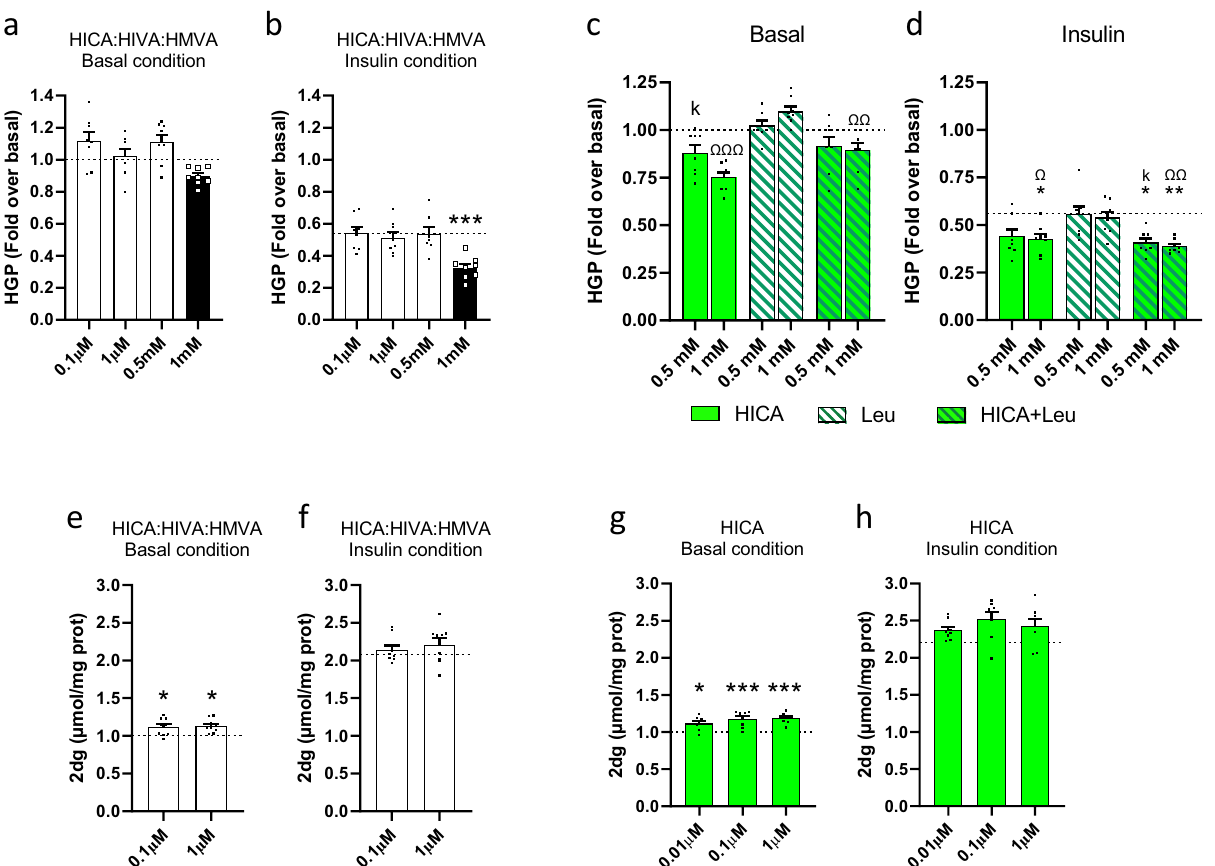
Fig. 5 BCHA are cell-autonomous modulators of liver and muscle glucose metabolism. a HGP of FAO cells treated with 0.1 µ M, 1 µ M, 0.5 mM and 1 mM mixture of HICA: HIVA: HMVA (white) at molar ratio 1: 1: 0.5 in basal condition. b HGP of FAO cells treated with 0.1 µ M, 1 µ M, 0.5 mM and 1 mM mixture of HICA: HIVA: HMVA at molar ratio 1: 1: 0.5 in insulin-treated condition. c HGP of FAO cells treated with 0.5 and 1 mM of HICA (lawn green), leucine (white, hatched green), or a combination of both (lawn green, hatched green) in basal condition. d HGP of FAO cells treated with 0.5 and 1 mM of HICA, leucine, or a combination of both in insulin-treated conditions. e 2dg uptake of L6 cells treated with 0.1 and 1 µ M mixture of HICA: HIVA: HMVA at molar ratio 1:1:0.5 in basal condition. f 2dg uptake of L6 cells treated with 0.1 and 1 µ M mixture of HICA: HIVA: HMVA at molar ratio 1:1:0.5 in insulin-treated condition. g 2dg uptake of L6 cells treated with 0.01, 0.1 or 1 µ M of HICA in basal condition. h 2dg uptake of L6 cells treated with 0.01, 0.1, or 1 µ M of HICA in insulin-treated condition. Data are expressed as mean ± SEM. Vs control: * p < 0.05 versus control, *** p < 0.001. HICA 0.5 mM vs HIVA 1 mM: ∂∂ p < 0.01. Vs Leu 0.5 mM: K p < 0.05, KK p < 0.01, KKK p < 0.001. Vs Leu 1 mM: Ω p < 0.05, ΩΩ p < 0.01, ΩΩΩ p < 0.001. The basal and insulin controls are represented by a dash line. n = 8 – 9 independent experiments. One-way ANOVA followed by Dunnett ’ s post hoc test vs